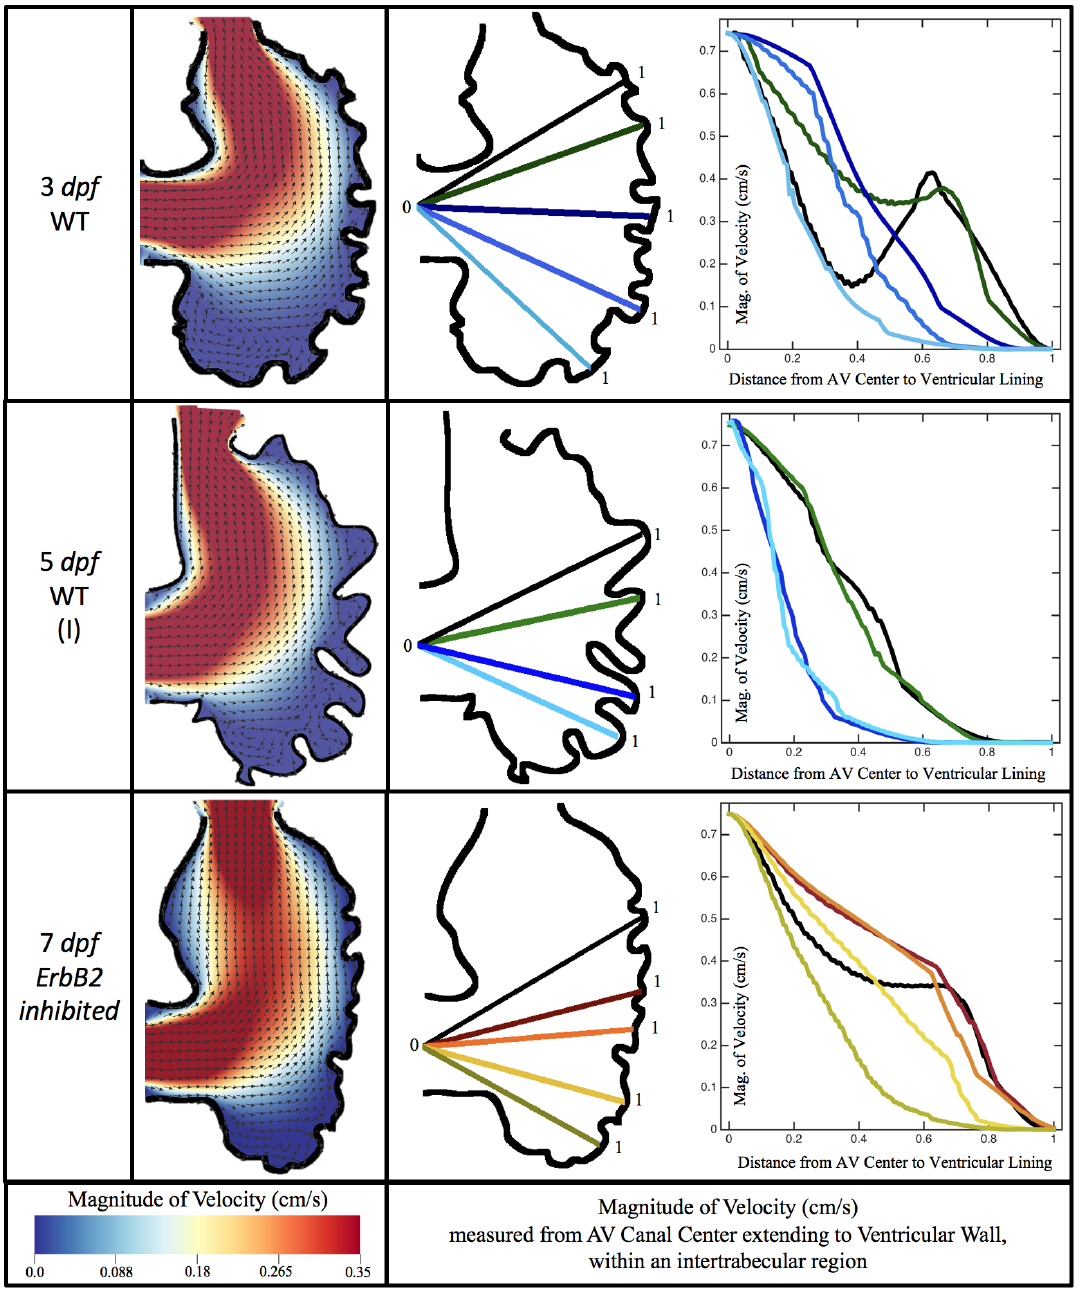
Figure 6. Simulation results for a 3 and 5 dpf WT (I) and 7 dpf ErbB2 inhibited zebrafish for Re = 1. The magnitude of velocity (cm/s) is given by the colormap, and the arrows show the direction of flow once steady state is reached (left). The panels on the right show the magnitude of velocity along lines drawn from the center of the AV canal to the ventricular lining between the trabeculae. Note that these lines are shown in the middle